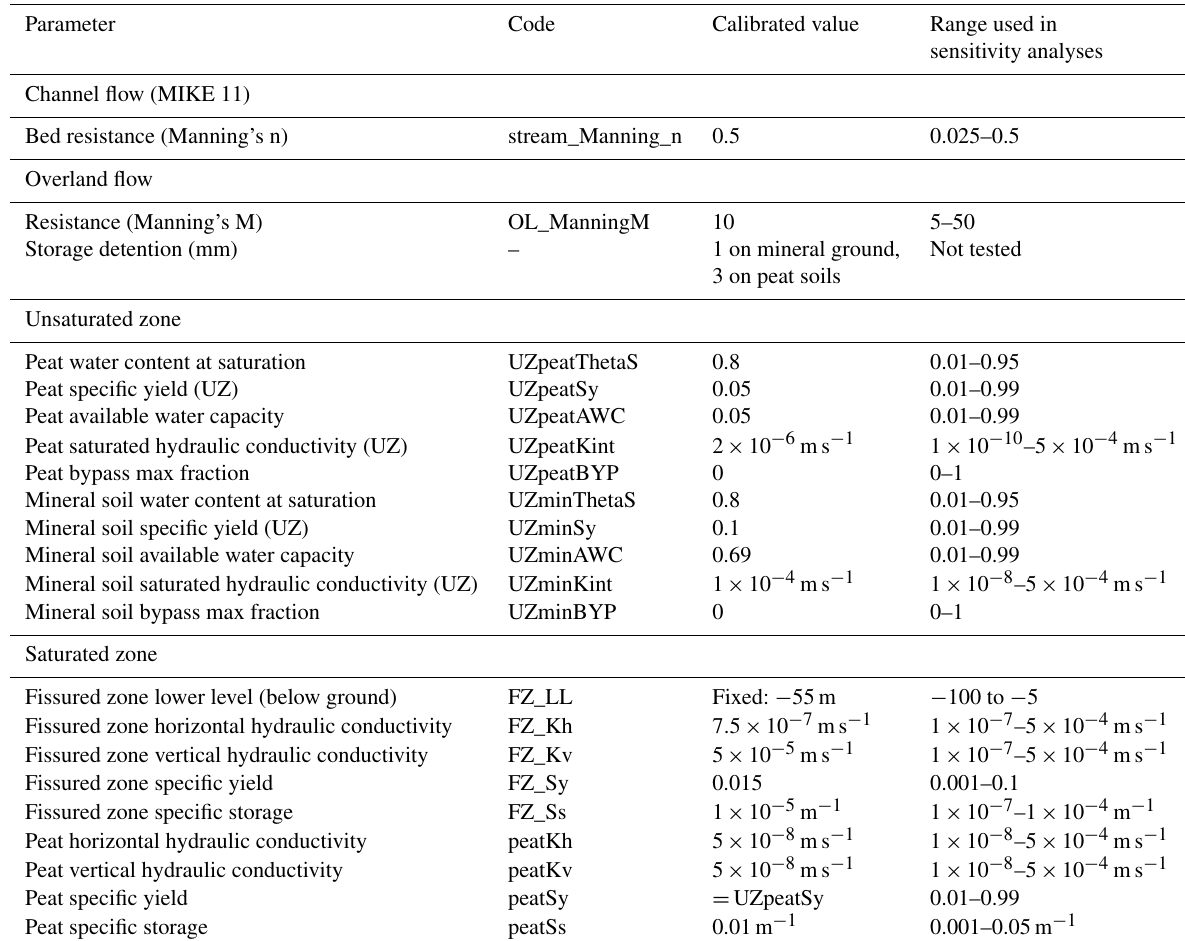
Table 3. Calibration parameters of the MIKE SHE/MIKE 11 model of the Dauges catchment, including their final values and the range used in sensitivity